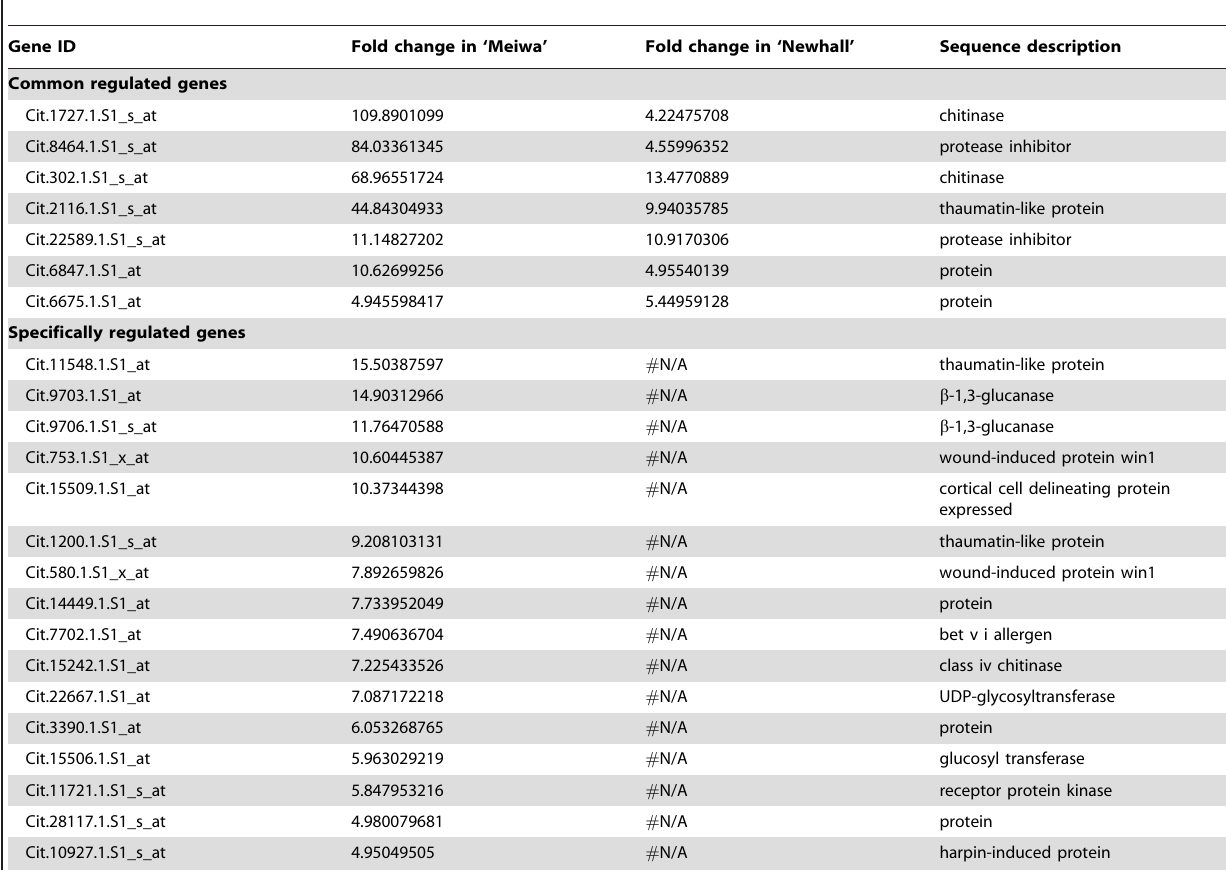
Table 3. Significantly enriched genes related to biotic stimulus response that are regulated in common between ‘Meiwa’ and ‘Newhall’ or specifically regulated in